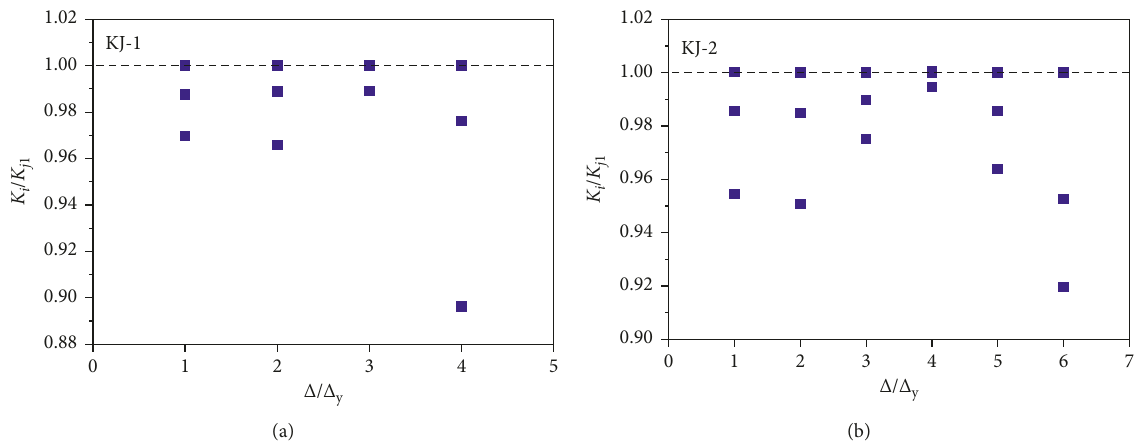
Figure 8: Stiffness degradation of specimen under the same cyclic displacement: (a) specimen KJ-1; (b) specimen